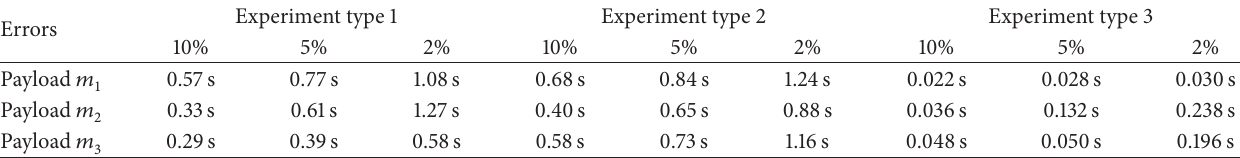
Table 2: Algebraic identification: convergence time for the different experiments and